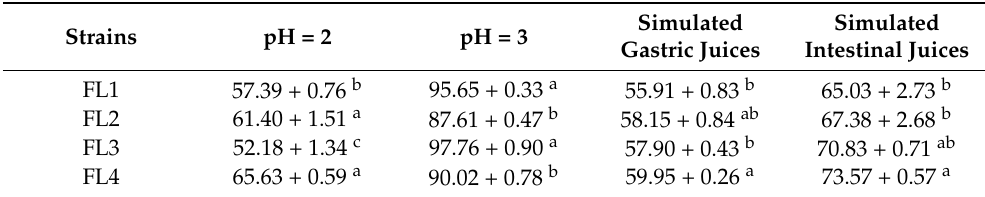
Table 2. Survival rate (%) of Limosilactobacillus fermentum strains under simulated gastrointestinal tract